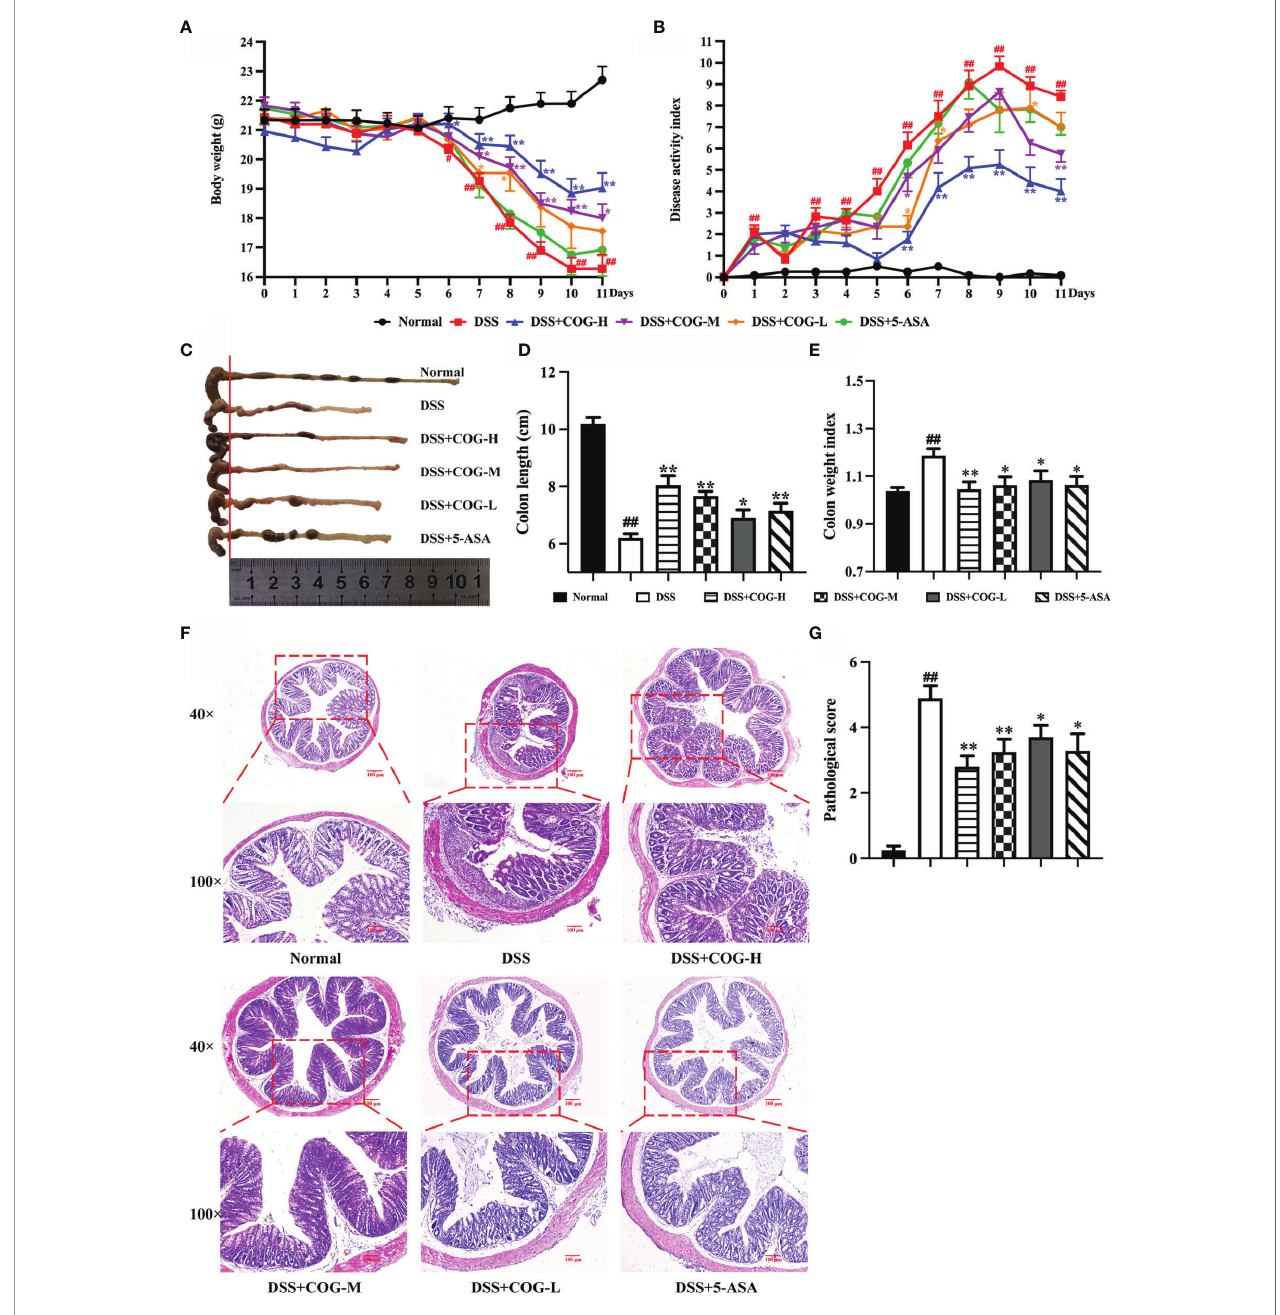
FIGURE 3 | COG treatment ameliorated DSS-induced experimental colitis. (A) Body weight. (B) Disease activity index (DAI) score. (C) Representative pictures of colon gross appearance and colon length. (D) Colon length. (E) Colon weight index. (F) Representative microscopic pictures of H&E-stained sections (magni fi cations: ×40 and ×100). (G) Pathological injury score. Data were presented as mean ± SEM ( n = 8 – 12). # p < 0.05 and ## p < 0.01 compared to the normal group; * p < 0.05 and ** p < 0.01 compared to the DSS